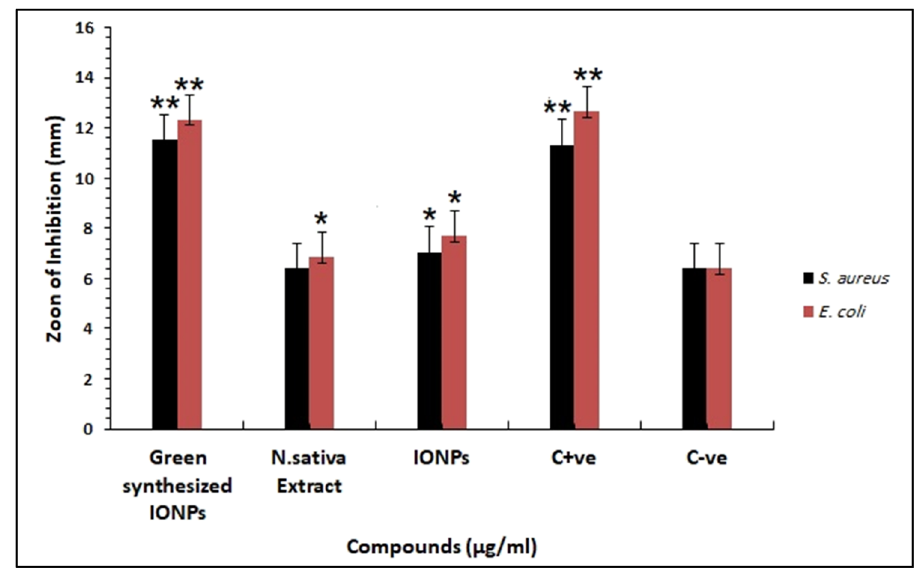
Figure 8: Inhibitory e ff ects of the green - synthesized IONPs, IONPs, N. sativa extract, and erythromycin ( C + ve ) against pathogenic bacteria ( E. coli and S. aureus ) using disc di ff usion assay. The results were compared with the DW as a negative control ( C − ve ) . ** Highly signi fi cant